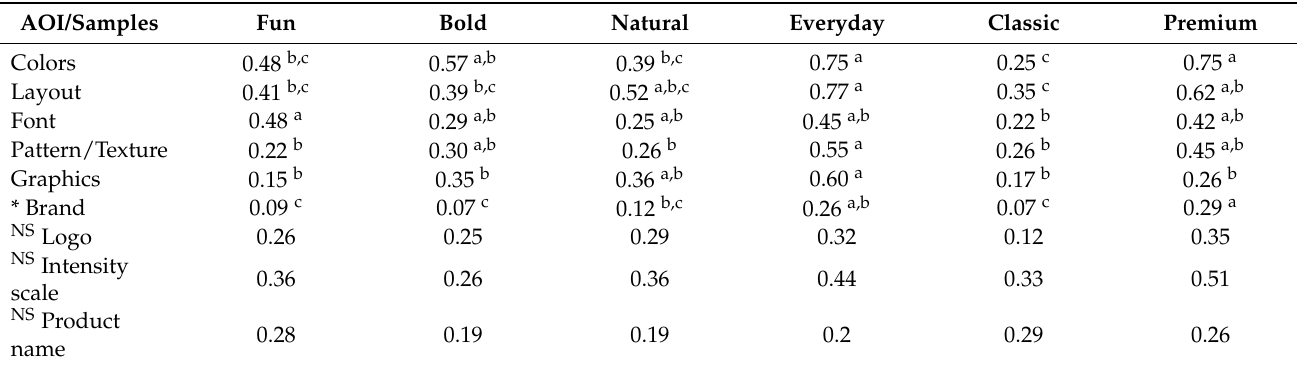
Table 6. McNemar test values from the area of interest (AOI) check all that apply test for the six different label samples (Figure